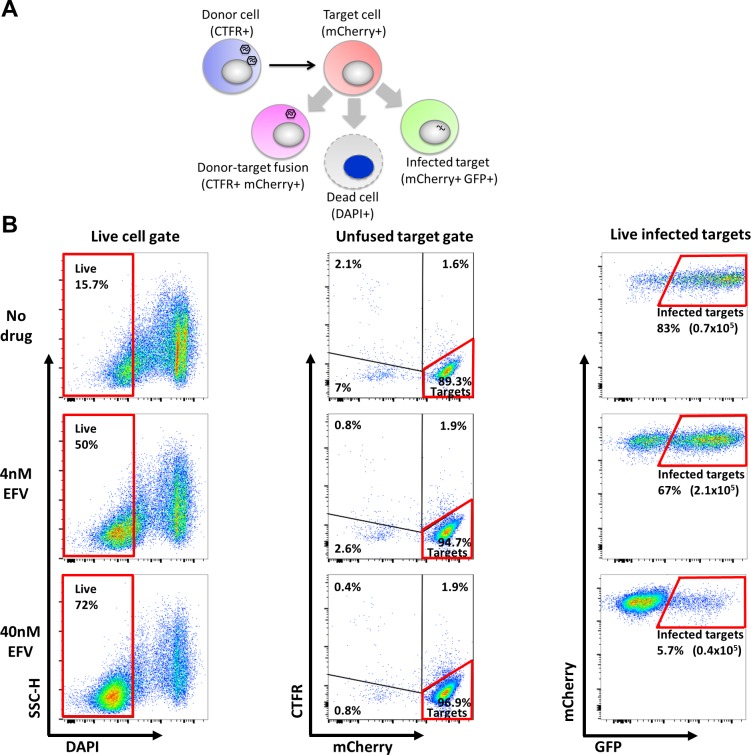
Gating strategy for coculture infection with wild type HIV.(A) Possible outcomes of donor cell-target cell interactions are target cell infection, fusion, and target cell death. Each outcome is traced by fluorescent markers for donor cells (Cell Trace Far Red, CTFR), target cells (mCherry), infected cells (GFP) and death (DAPI). Live infected target cells were DAPI negative and mCherry and GFP positive. Donor-target fusions were excluded by excluding all CTFR-positive cells. (B) Representative flow cytometry scatter plots used in gating strategy. First, live cells were selected using the absence of DAPI fluorescence (left column). Next, target cells were separated from donor cells and donor-target fusions using CTFR and mCherry (middle column). Last, the number of infected targets was determined by GFP fluorescence (right column). Percentages represent fraction of the population in the gate and numbers in parentheses represent the number of infected cells/ml. Areas marked in red represent selection gates for live infected targets.